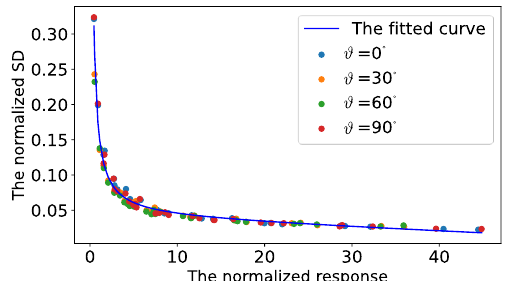
Figure 4. An illustration of the normalized SDs vs. the change in rotation angles. The blue, or- ange, green and red points denote the sampling from the rotation angles 0, 30, 60 and 90 degrees, respectively. The blue curve is fitted by all sampling. It can be seen that the fitted curve successfully describes the relationship between the normalized SDs and the normalized responses at different rotation